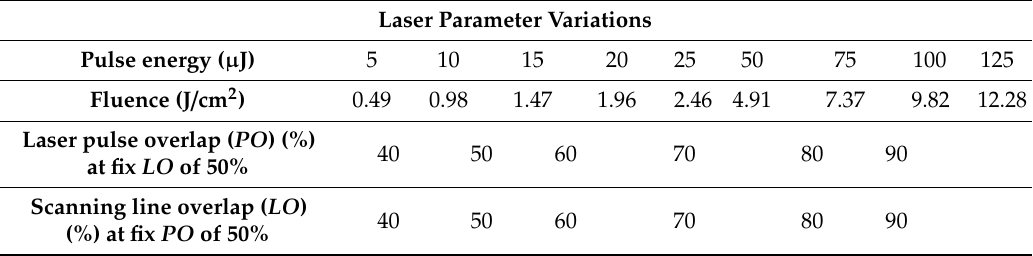
Table 1. Laser parameter setting. Laser pulse and scanning line overlap were varied for each pulse energy/fluence value.